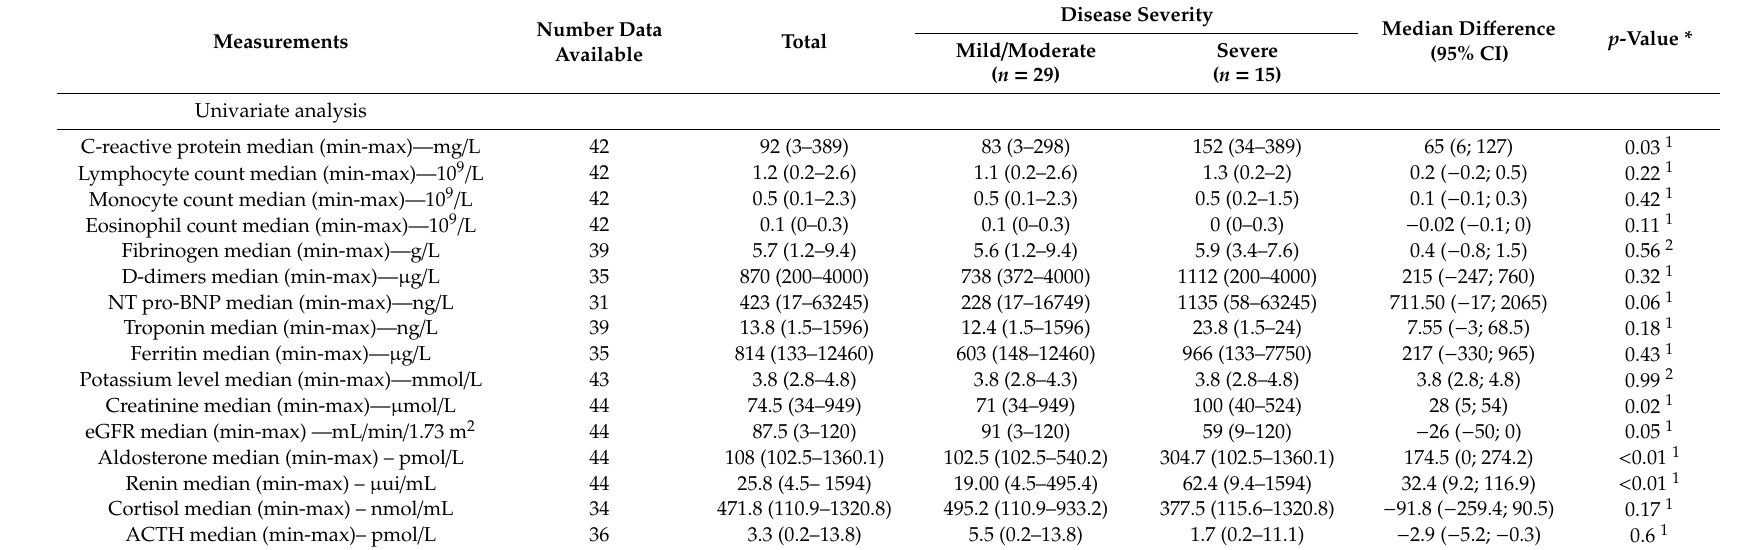
Table 3. Biological findings at inclusion (on Day 0) according to disease severity of patients with Covid-19 infection classified in two groups: mild / moderate (OS max ≤ 4) and severe (OS max ≥